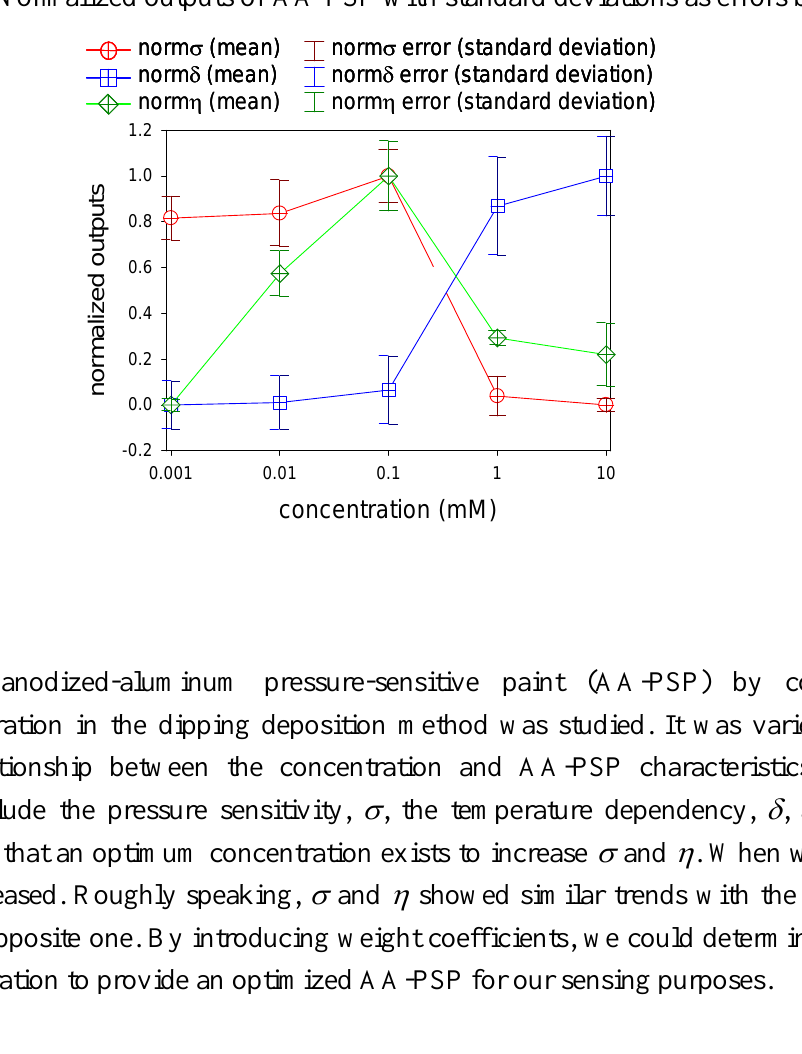
Figure 10. Normalized outputs of AA-PSP with standard deviations as errors